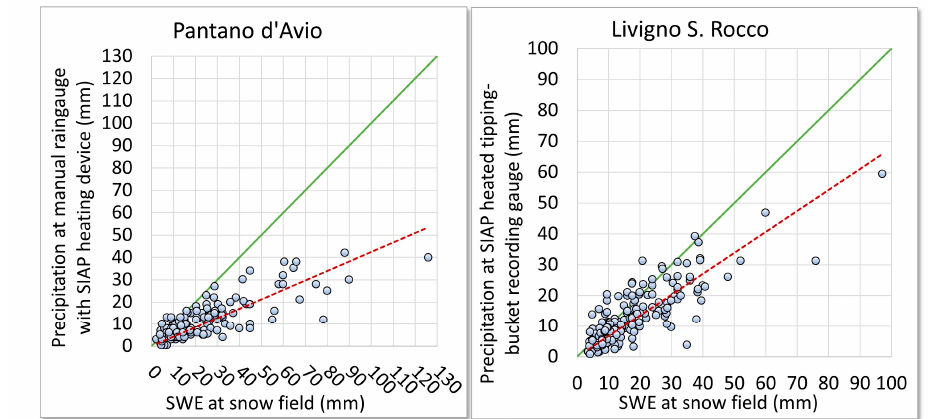
Figure 3. Comparison between melted snow measured daily by rain gauges and SWE of freshly-fallen snow manually measured at snow field sites. Plots refer to Pantano d'Avio (2390 m a.s.l., period 1987– 2014) and Livigno S.Rocco (1865 m a.s.l., period